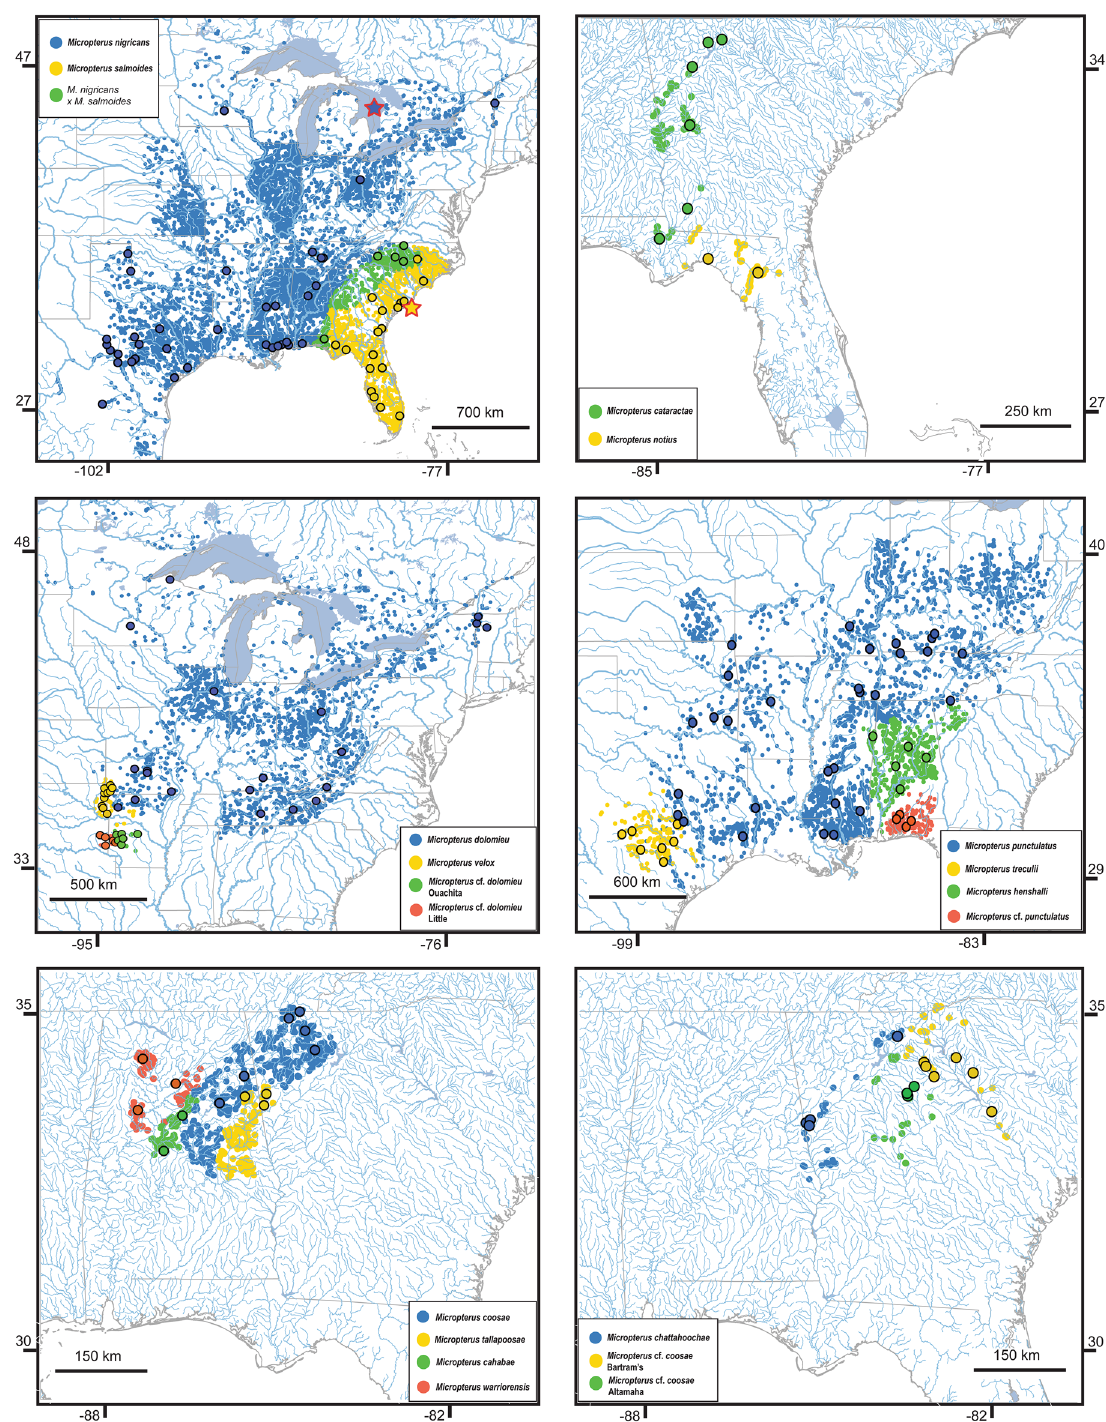
Figure 1. Geographic ranges of all species in Micropterus as delimited in this study. Circles mark museum collections records with GPS coordinates retrieved from Fishnet2 (http:// www. fishn et2. net/). Black outlined circles mark the collection localities of specimens used in this study. The type locality of Micropterus nigricans and Micropterus salmoides are marked with red-bordered stars. Maps created using personal R scripts. See Supplementary Table S1 for a complete list of specimens used in this